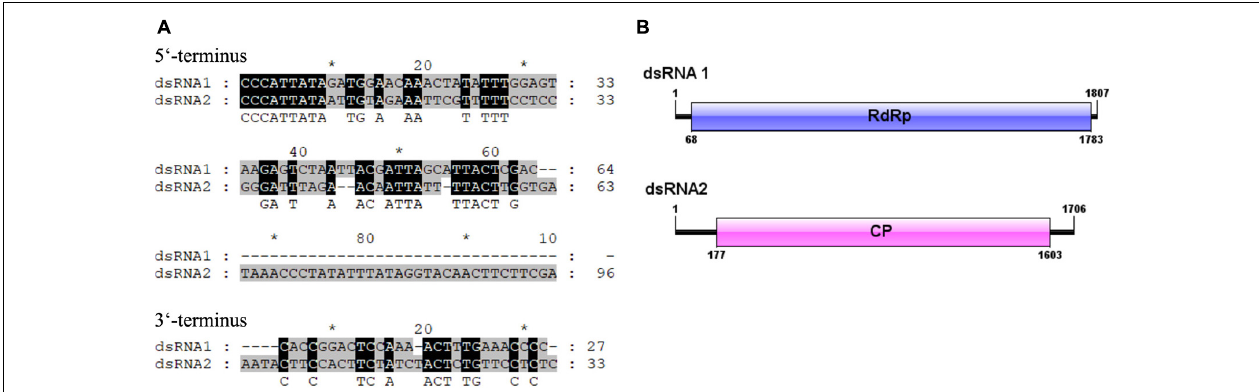
FIGURE 2 | (A) Terminal sequences between dsRNA 1 and dsRNA 2 were aligned and the identical sequences were indicated with reverse highlighting. (B) Schematic representation of the genome organization of virus Colletotrichum liriopes partitivirus 1 (ClPV1). ClPV1 contained two dsRNAs, dsRNA 1, and dsRNA 2, which encoded a putative RNA-dependent RNA polymerase (RdRp) and a coat protein (CP), respectively. The open reading frames (ORFs) were indicated by open bars and the 5 (cid:48) and 3 (cid:48) untranslated regions were indicated by single lines.